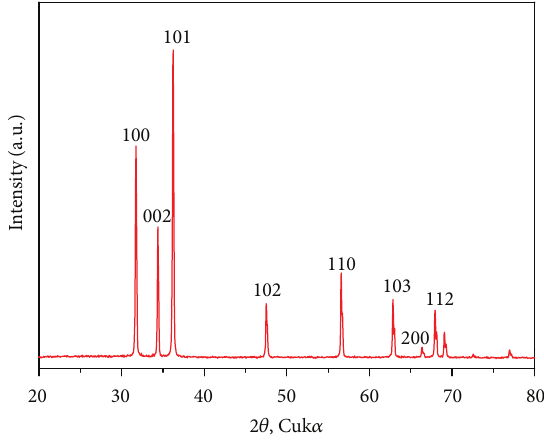
Figure 4: XRD pattern of the ZnO immobilized particles on glass